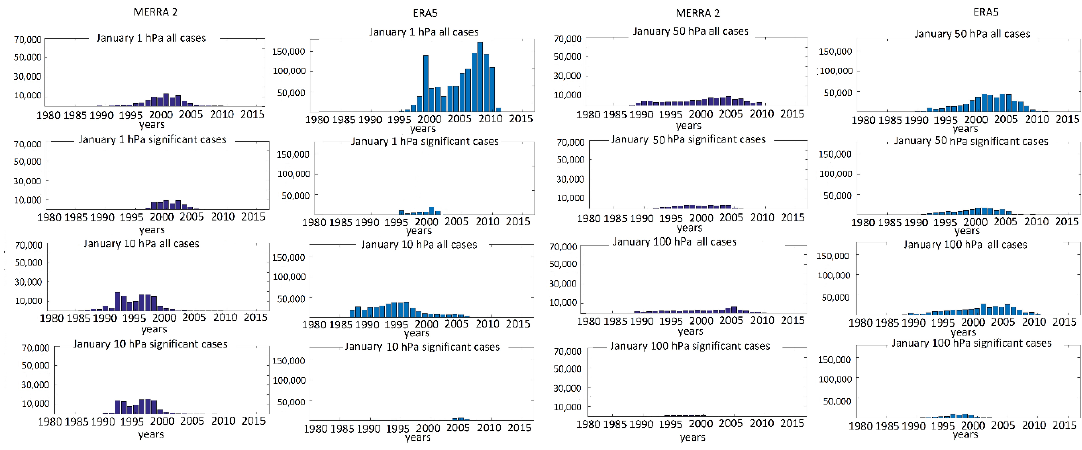
Figure 4. Number of grid points with temperature jumps during the period 1980–2018 for several pressure levels (1, 10, 50, and 100 hPa) in January of MERRA2 and ERA5 reanalyses. Significant cases mean application of variance condition.